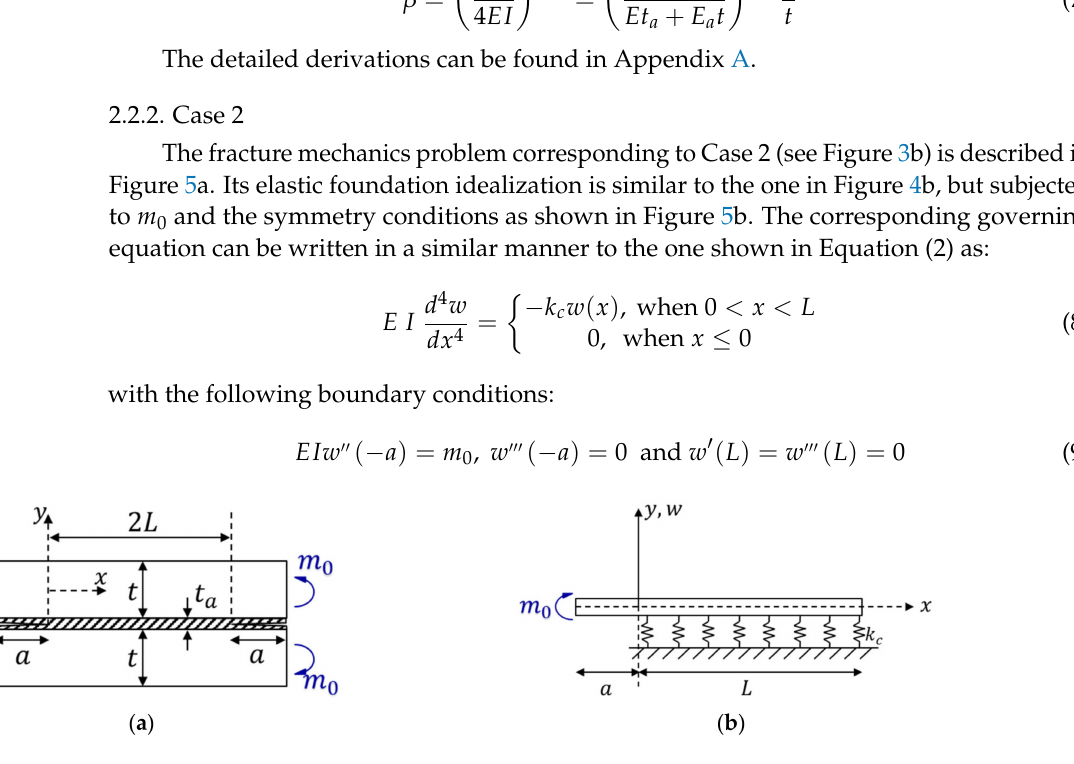
Figure 5. The crack problem definition for Case 2. ( a ) Geometry and load conditions. ( b ) Elastic foundation